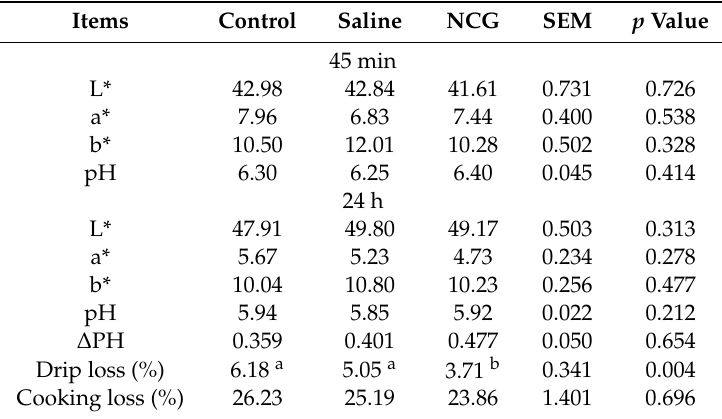
Table 5. Meat quality of pectoral muscle in broilers.